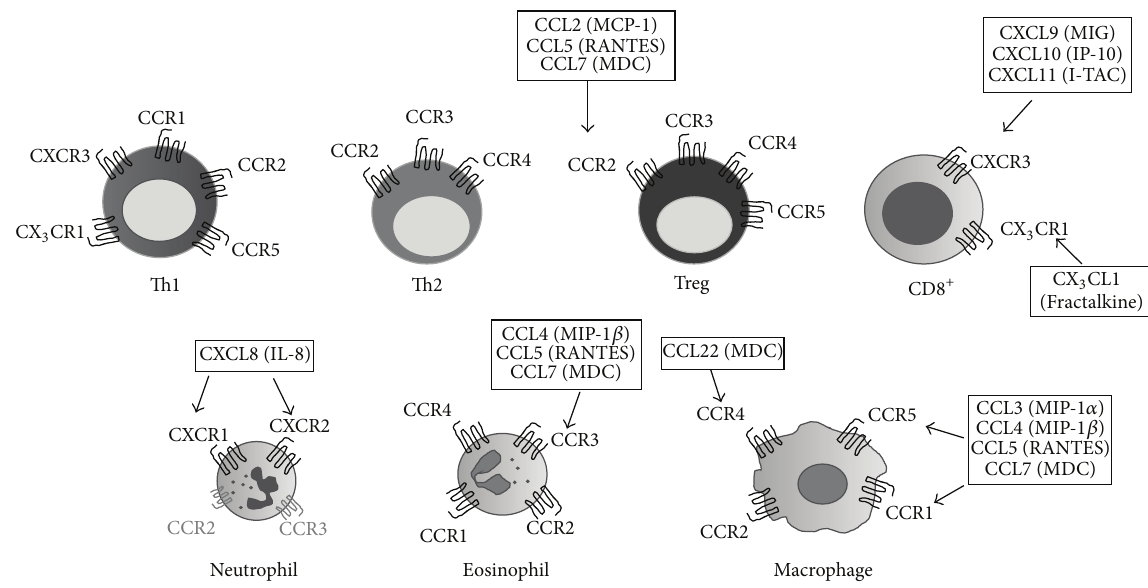
Figure 1: Summary of chemokines and their receptors investigated in this study. The chemokines interacting with their corresponding receptors are indicated once for each receptor but are valid for all cell types expressing these